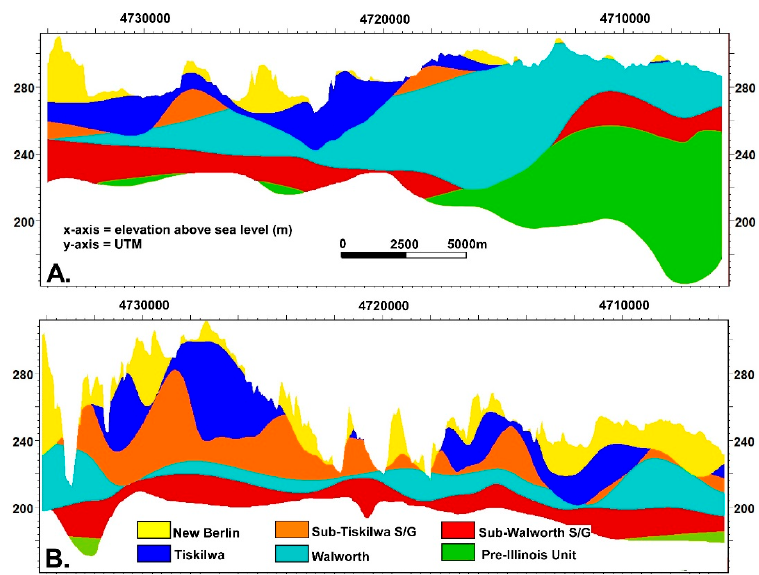
Figure 7. Cross sections of Quaternary sediments in Walworth County. Each section is north–south trending with north to the left. ( A ) Section is constructed along the 358,000 UTM line indicated